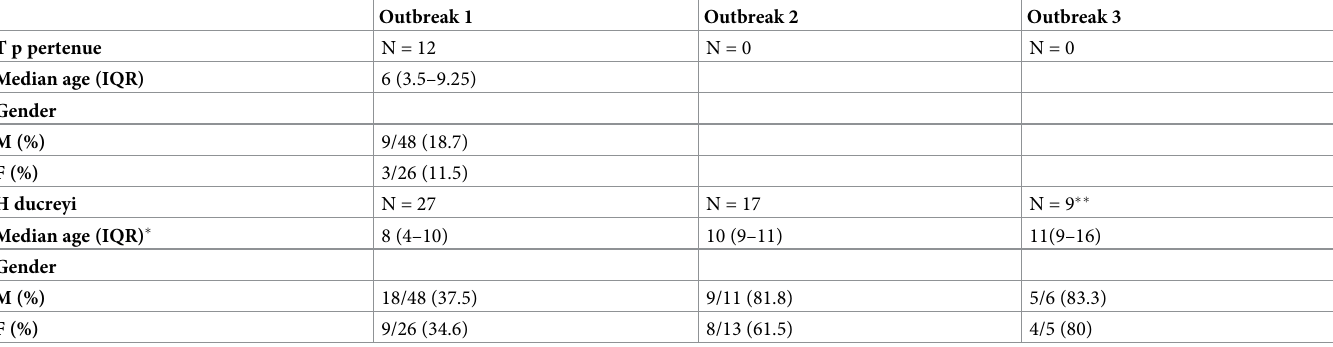
Table 5. Characteristics of children with PCR confirmed yaws ( T . p . pertenue ) and with H . ducreyi lesions.